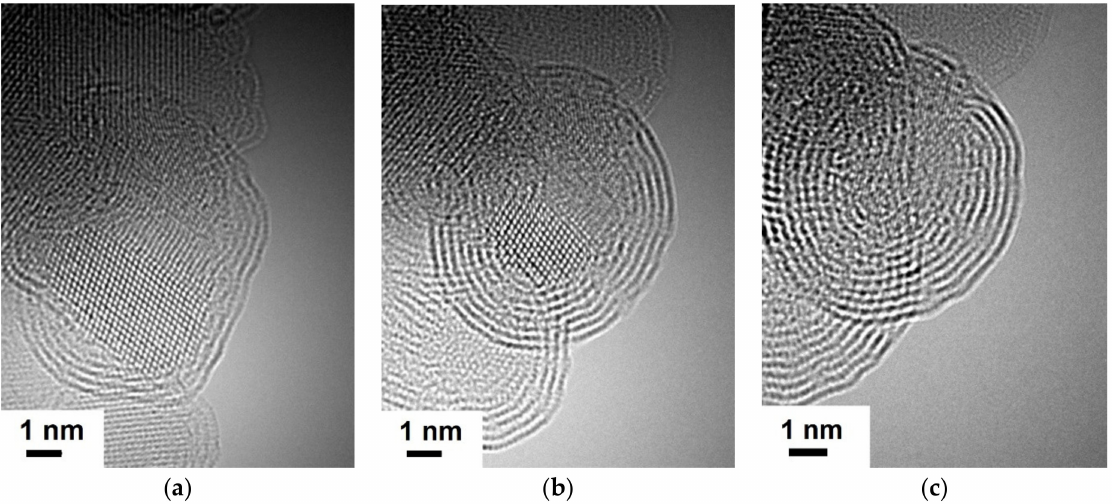
Figure 5. Transformation of a detached nanodiamond particle exposed to local heating by electron beam; images were produced with an interval of 60 s (TEM JEOL JEM 2100 F/Cs, accelerating voltage 200 kV): ( a ) big diamond core; ( b ) small diamond core; ( c ) complete transformation.